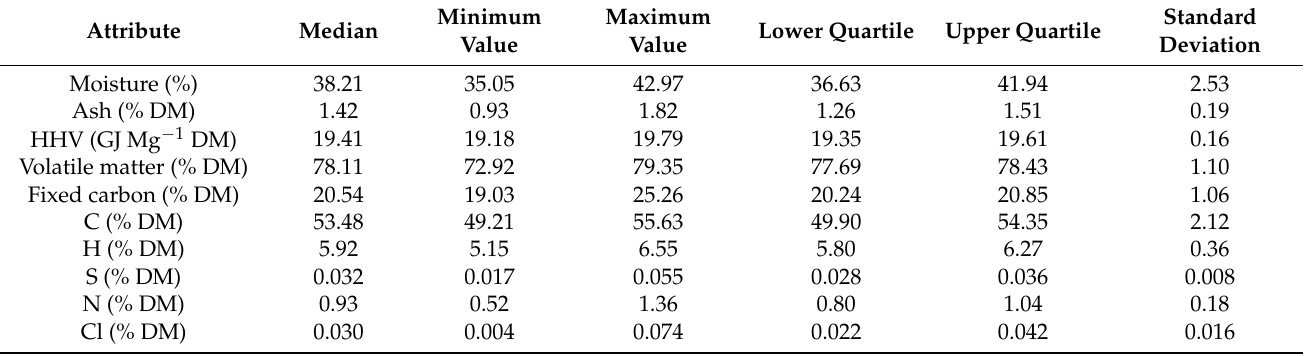
Table 6. Selected statistical analysis indicators for the black locust characteristics under study.